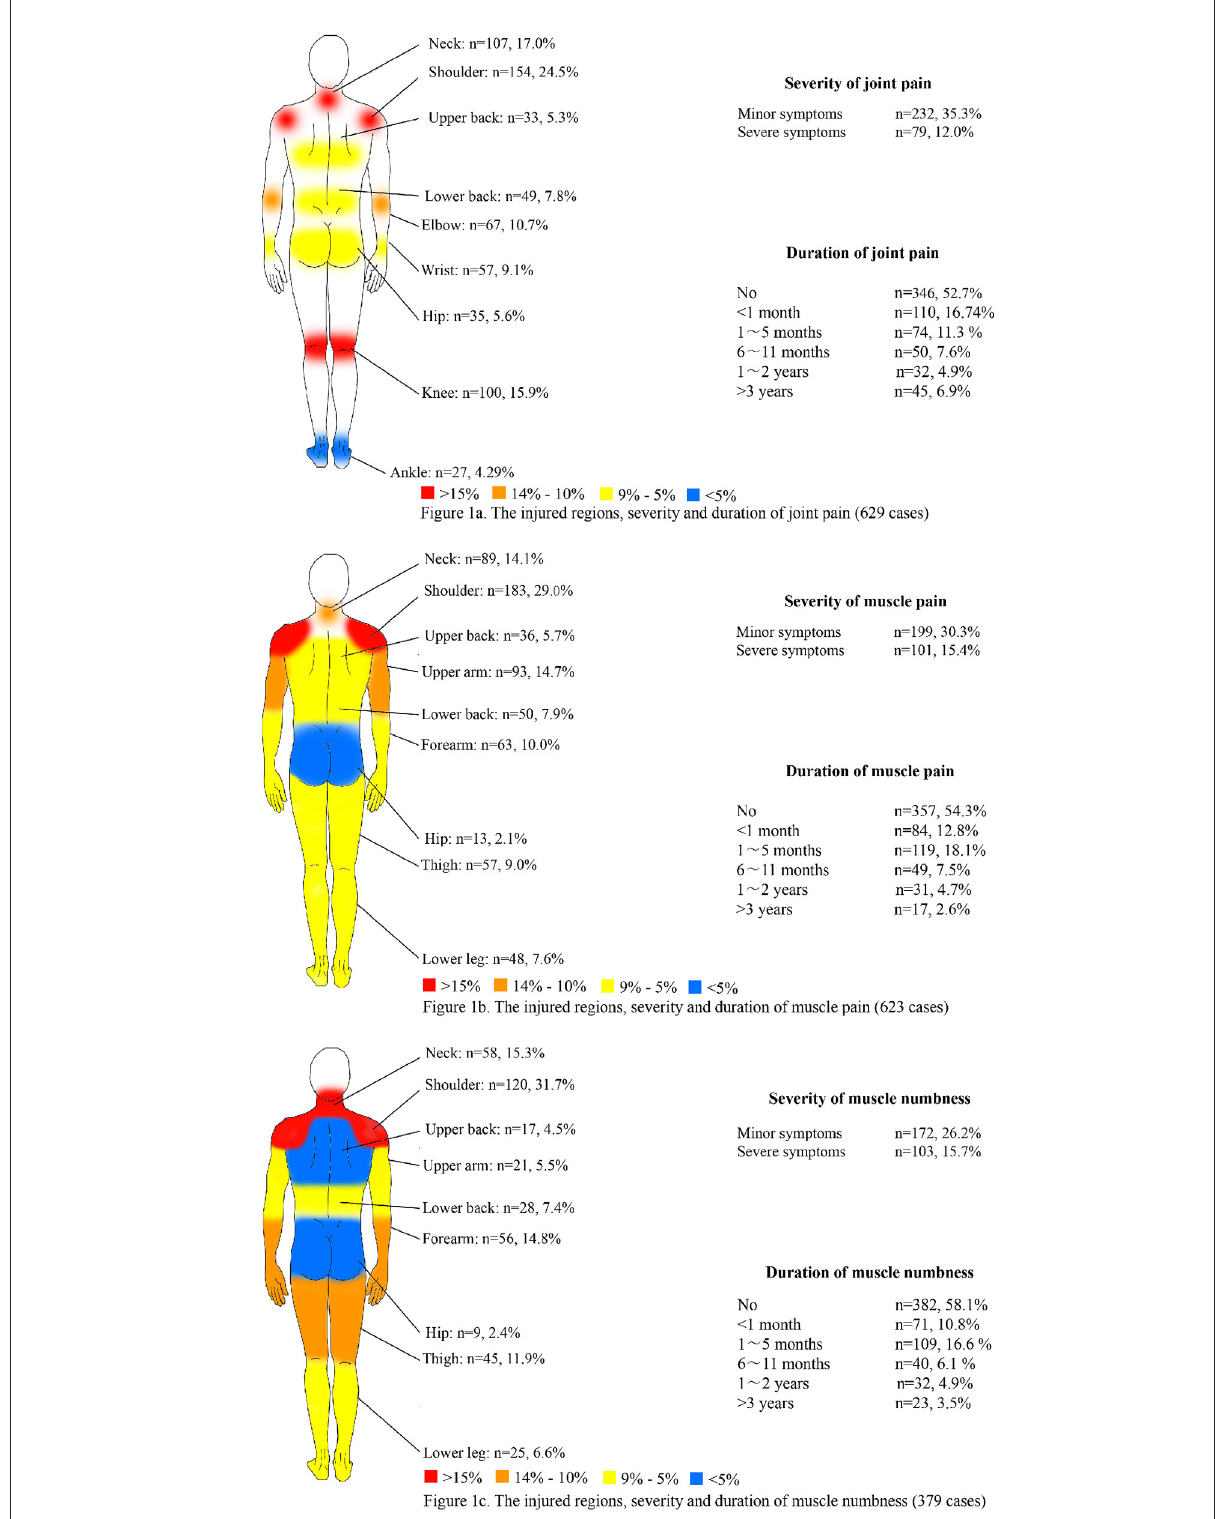
FIGURE1 The injured regions, severity and duration of MSD